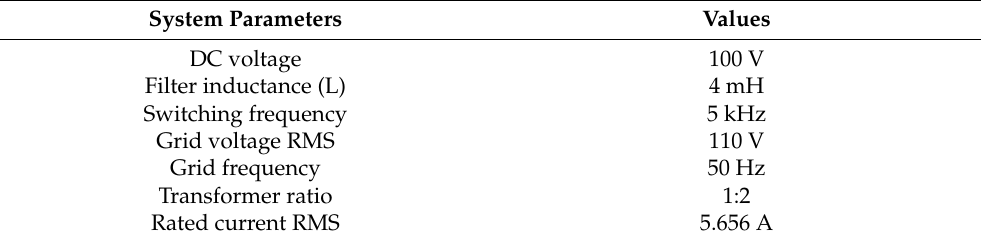
Table 1. System parameters.